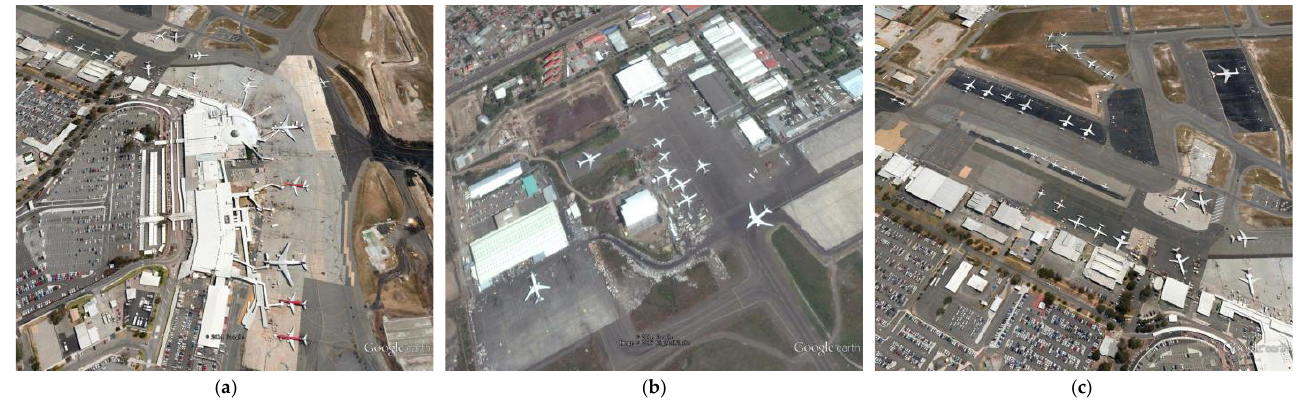
Figure 1. Some aircraft examples in RSIs. ( a ) Complex geo-graphical environmental background; ( b ) aircraft targets in different poses; ( c ) aircraft targets in various sizes. ( b ) aircraft targets in different poses; ( c ) aircraft targets in various